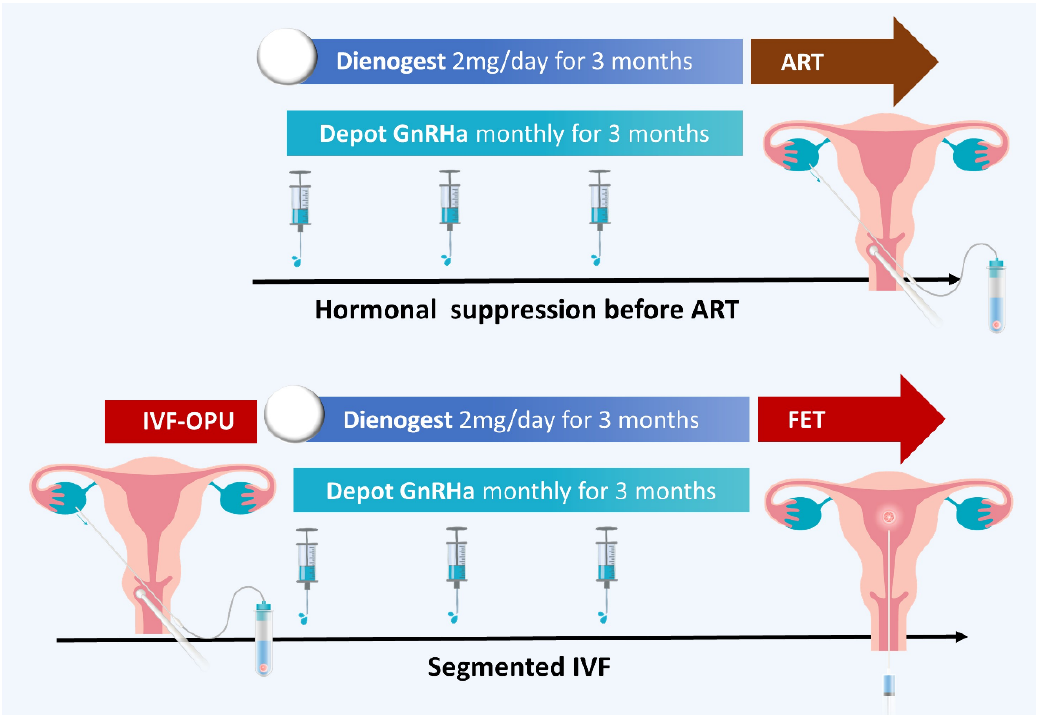
Figure 6. Assisted reproductive technology for